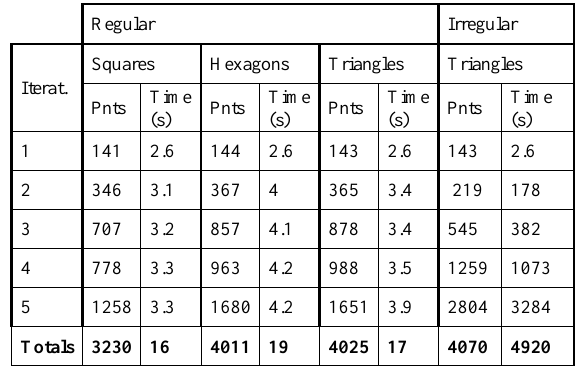
Table 1. Number of points and execution time